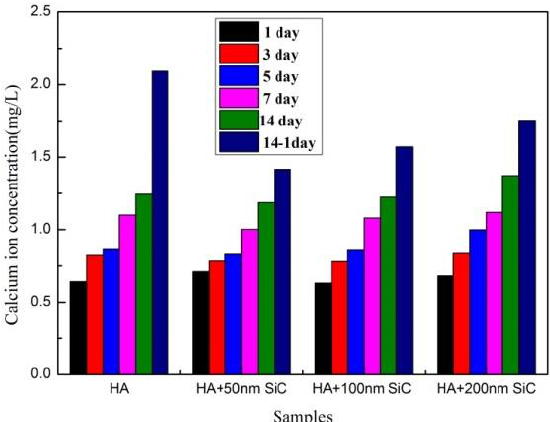
Figure 10. Calcium concentration of different SiC particle sizes.